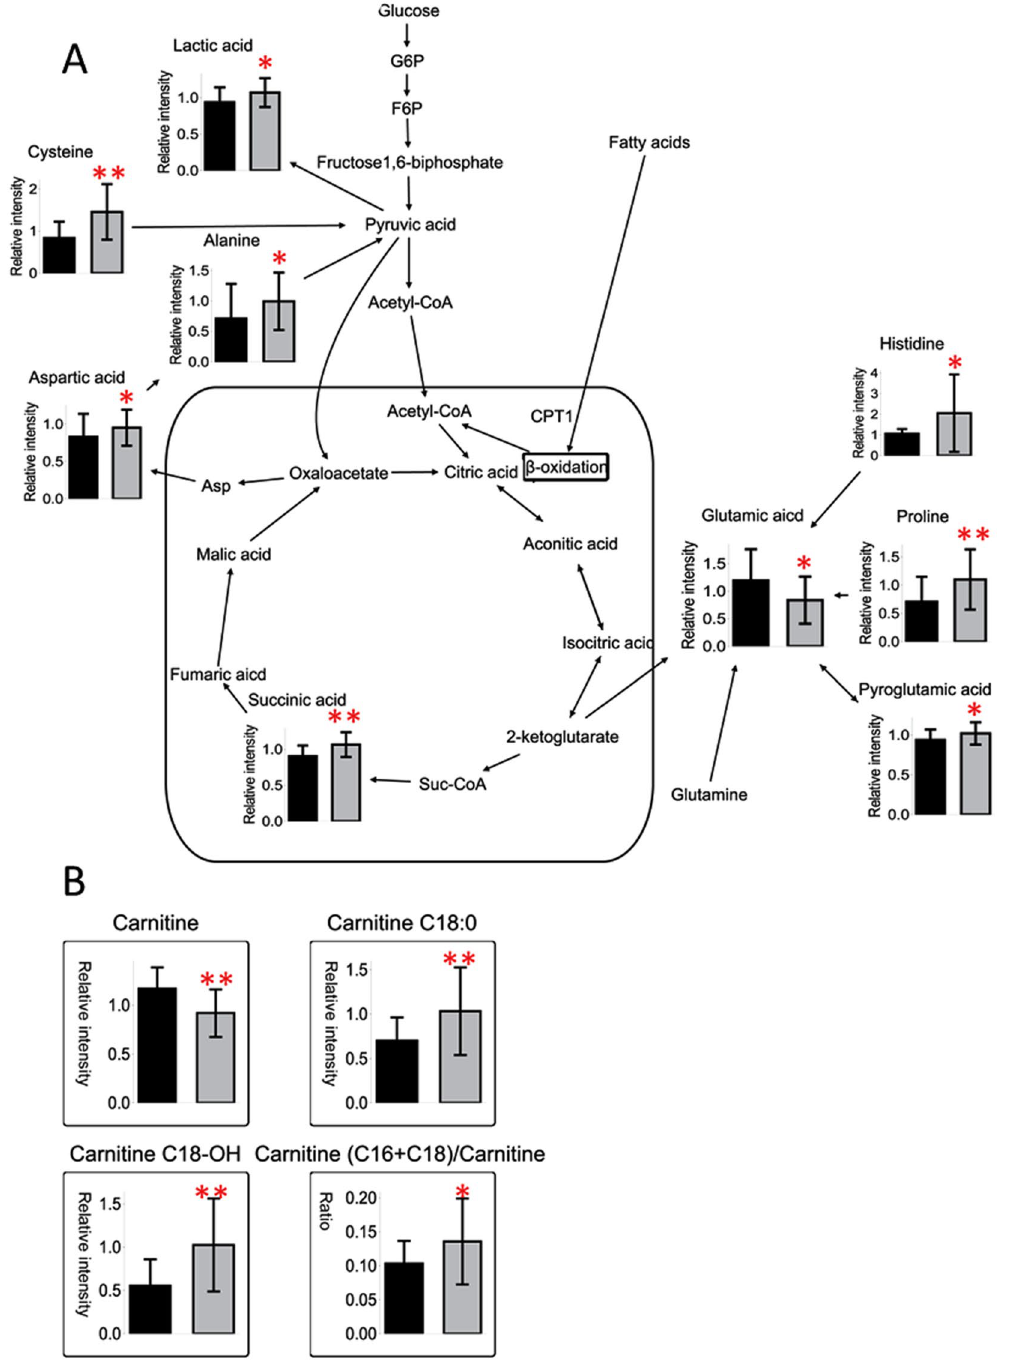
Figure 3. Mapping of differential metabolites related to energy metabolism ( A ). Relative serum levels of differentially expressed free carnitine, acylcarnitines with long chains, and the ratio of carnitines (C16 + C18) to carnitine ( B ). Data shown as mean ± SEM. * < 0.05, ** <